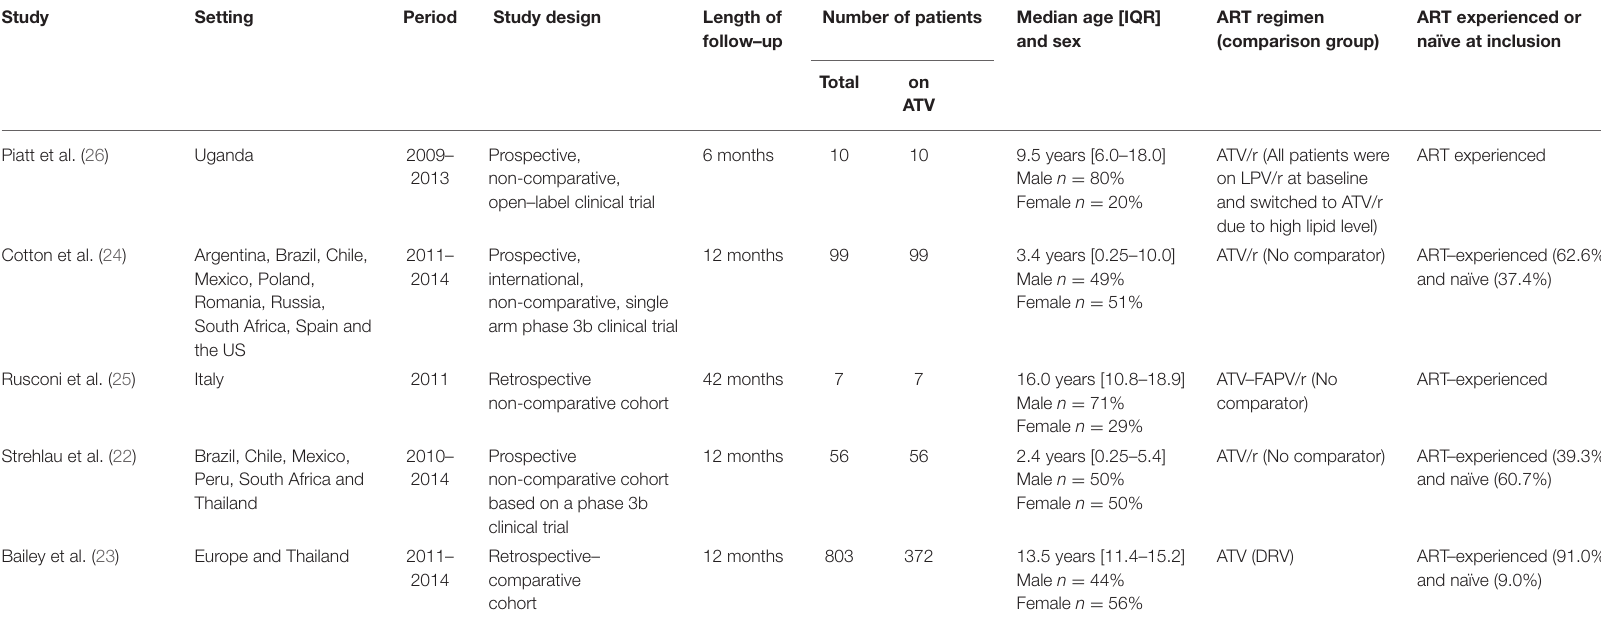
TABLE 1 | Characteristics of the five studies included and their study population in the atazanavir systematic review